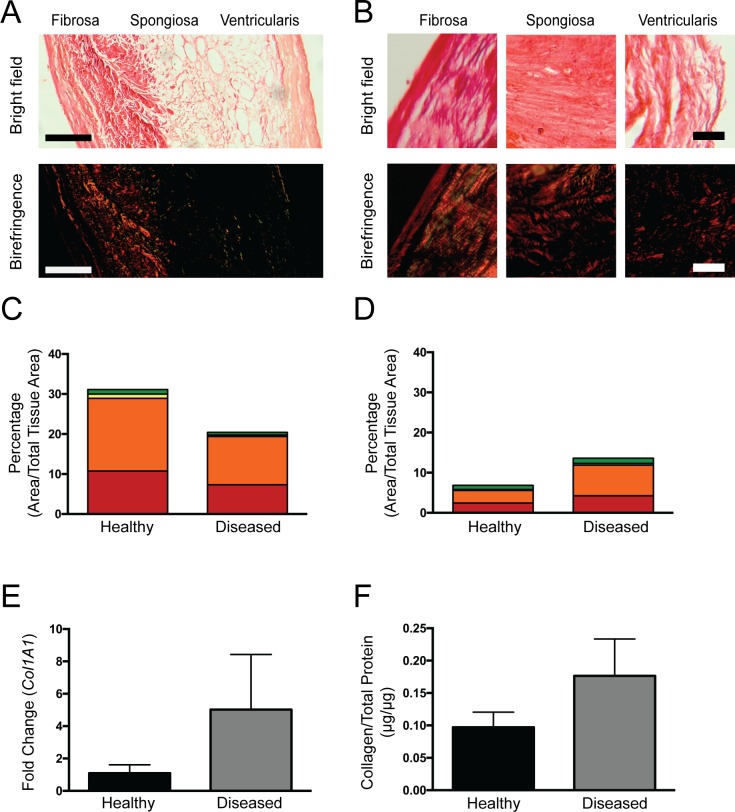
Visualization of collagen fibers via picrosirius red staining and quantification of collagen content.Picrosirius red staining of (A) healthy and (B) diseased leaflets was visualized using brightfield microscopy and polarized light. Birefringence hue and amount were quantified as a percent of total tissue area (N = 5, n = 3) in the (C) fibrosa and (D) spongiosa. Collagen production was also quantified via (E) qRT-PCR analysis of COL1A1 gene expression (N = 4, n = 3) and (F) measurement of total collagen protein via dot blot (N = 5 healthy; N = 4 diseased, n = 3).